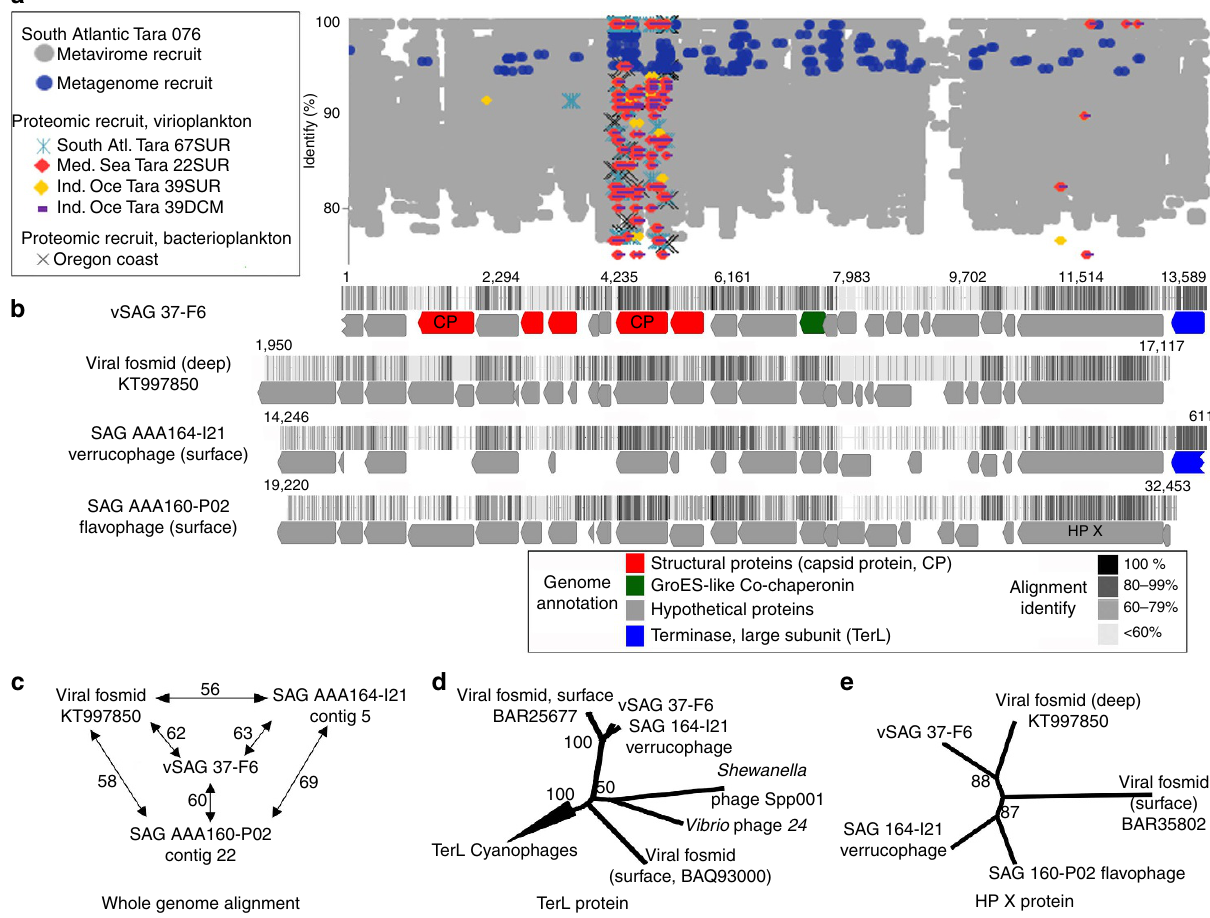
Figure 4 | Ecogenomics of the putative most abundant surface marine virus, the vSAG 37-F6. ( a ) Virome, microbial metagenome and proteome fragment recruitment in different data sets 3,31,62 . A hypervariable genomic island in virus 37-F6 was detected between genomic position 9,000 and 9,700 (unknown protein). ( b ) Genome annotation, synteny and whole-genome alignment of vSAG 37-F6 with closest viral relatives 26,29 . Colour in the alignment (from black to white) denotes identity values among all four genomes for each genome position. ( c ) Whole-genome similarity with closest viral relatives. ( d , e ) Phylogeny of large subunit of viral terminases (TerL) and the large conserved hypothetical protein X (HP X) based on maximum-likelihood method. Bootstrap values are indicated in